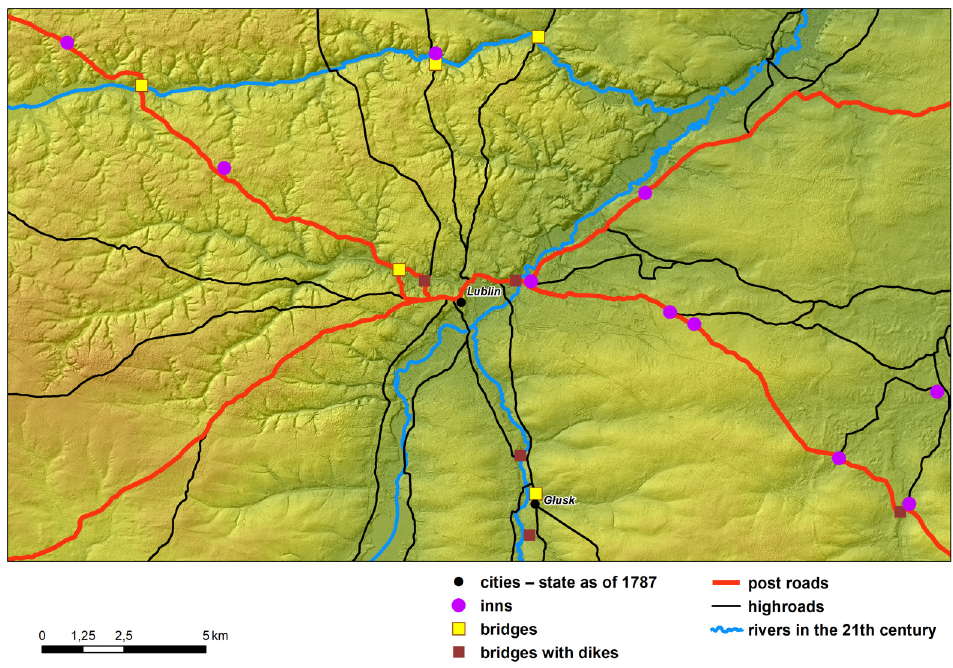
Fig. 9. The layout of the reconstructed transport network in the Lublin area in the second half of the 18th century (author’s own